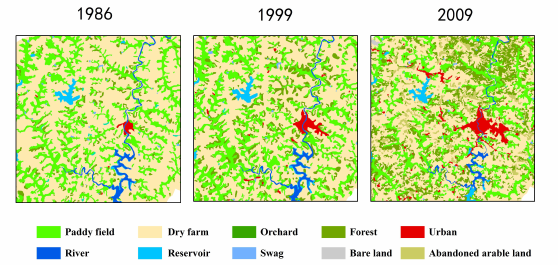
Figure 8 The expansion of the urban area for different study